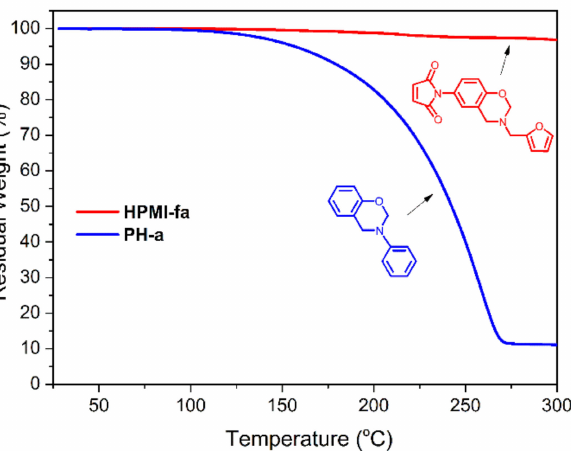
Figure 20. Thermogravimetric analysis of HPMI-fa and PH-a, showing nearly complete prevention of the evaporation of the resin prior to polymerization [215]. Copyright 2019. Reproduced with permission from American Chemical